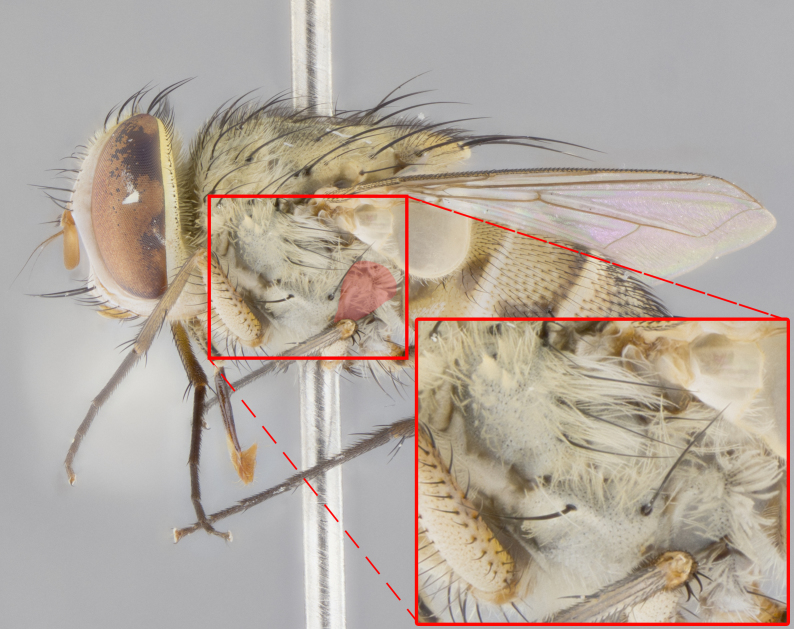
lateral habitus of Telothyria
peltata
sp. n. male (voucher n. DHJPAR0050298) inset detailing the presence of plumose meral setae typical of all the males of the genus.